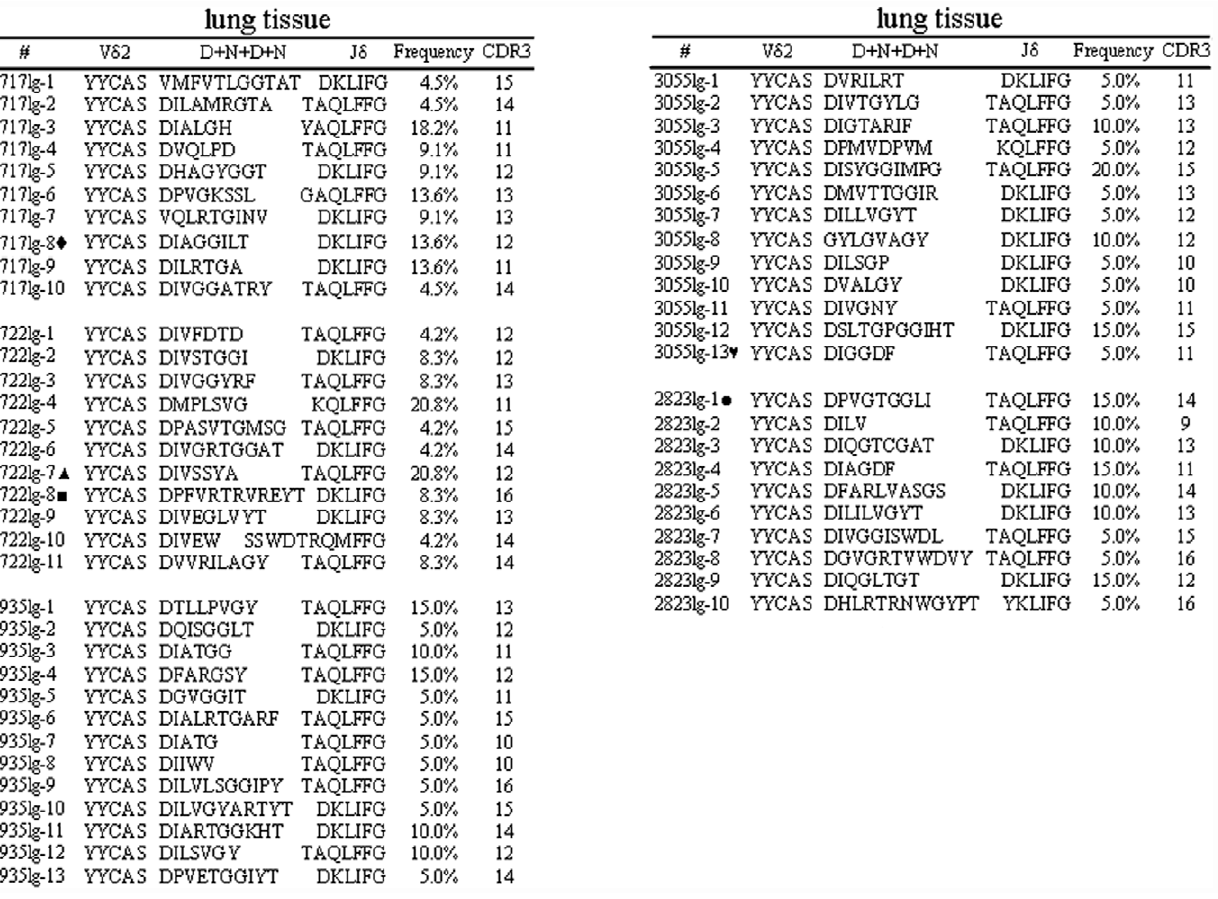
Figure 1. Broad T cell repertoire in V c 2V d 2 T-cell subpopulation in lymphoid system during primary Mtb infection of macaques. Shown are individual V d 2 TCR clones isolated from PBL (left) and lymphocytes of spleen tissues (right) from 5 Mtb-infected macaques. The flow cytometry data indicating cellular expansion of V c 2V d 2 T cells in spleen were described in the text. Note that spleen lymphocytes in which major expansion of V c 2V d 2 T cells was seen were used for RNA isolation, cDNA synthesis and V d 2 TCR sequence analyses. Note polyclonal sequences of V d 2 TCR in cDNA derived from spleen lymphocytes and PBLs. Frequencies were expressed as the number of individual clones among the total analyzed clones. Similar data indicating polyclonal representation of V c 2V d 2 T cells in PBL before Mtb infection were also seen (data not shown). CDR3 were N presumably indicated based on the definition for TCR b CDR3 [9]. D indicates diversity region; N indicates non-determining region of TCR receptor ’ were present in the blood, lung and genes. Clones marked by ‘ ¤ ’ were present in the blood, lung and kidney (2717). Clones marked by ‘ # ’ and ‘ spleen(3055 and 2823). Clones marked by ‘ m ’ and ‘ & ’ were present in the blood and lung(2722).